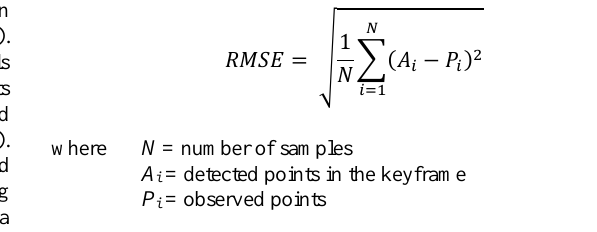
Figure 4. The 3D model of the monastery of St. Modestos.